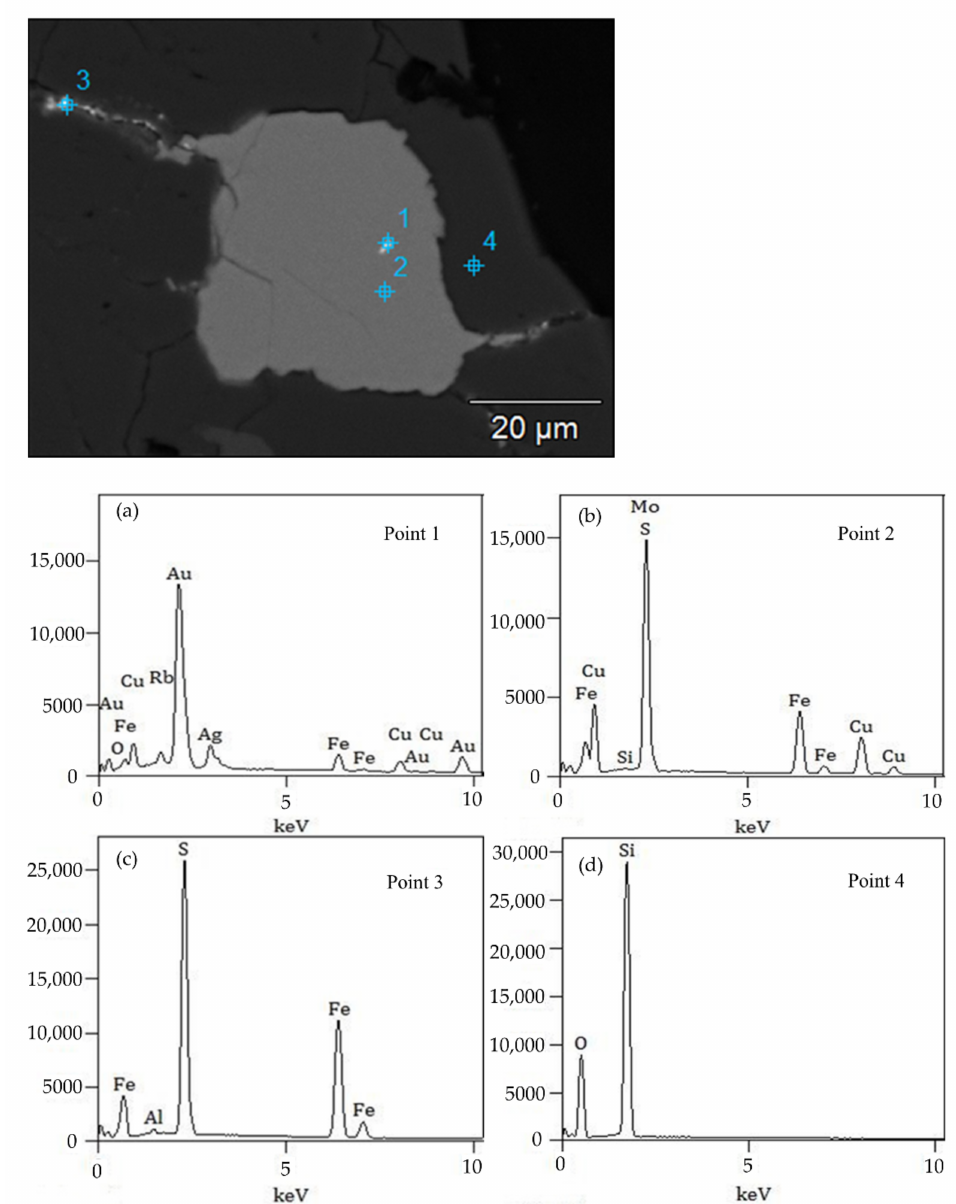
Figure 3. Backscattering electron detection of SEM micrograph of Au in the sample: ( a ) natural gold, ( b ) copper pyrites, ( c ) pyrite, ( d )